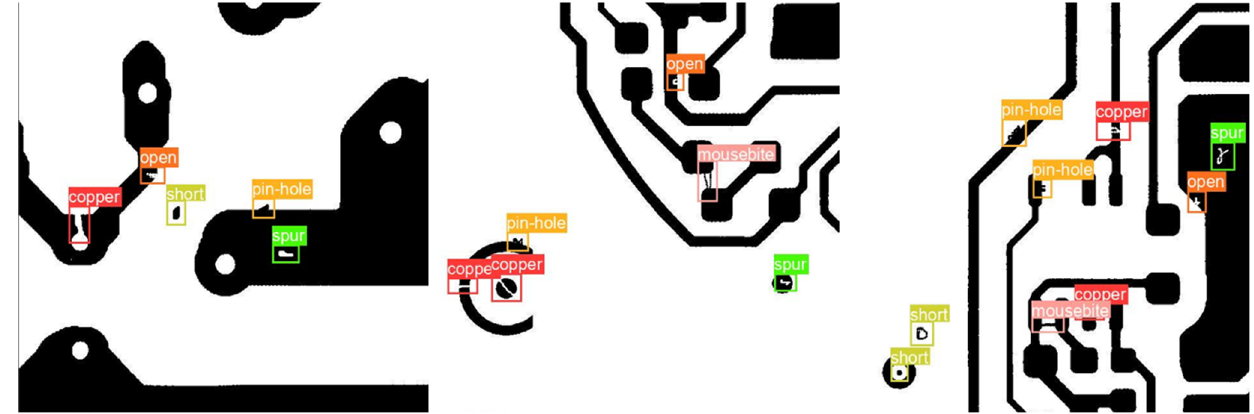
Figure 3. Defect samples that contain bounding boxes and classes of